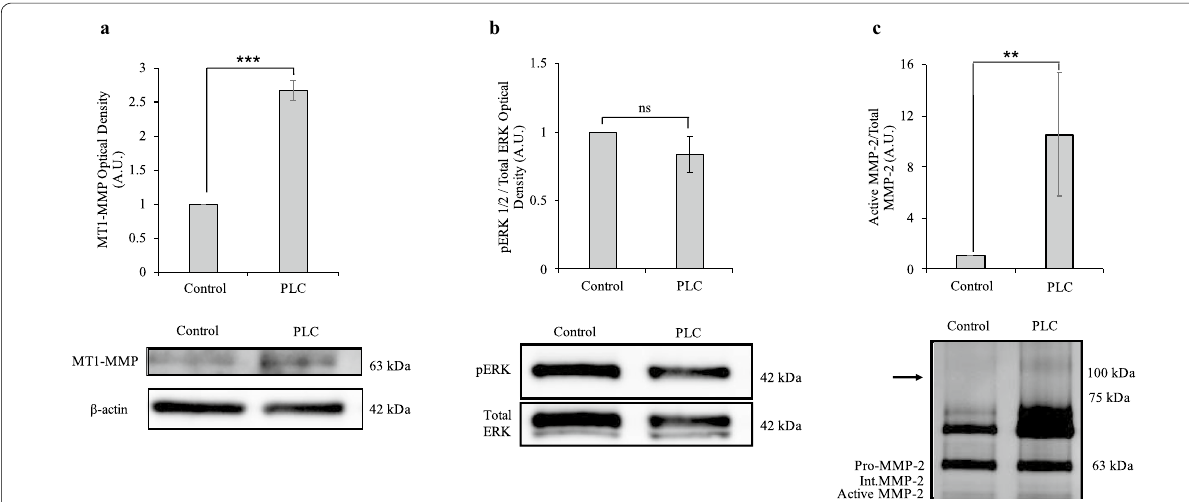
Fig. 6 PI-PLC treatment caused an increase in MT1-MMP protein and MMP-2 activity levels. a Densitometry quantification of MT1-MMP protein level normalized to β-actin in control A6 cells treated with PI-PLC. MT1-MMP protein levels significantly increased in PI-PLC-treated cells compared to untreated cells (set to 1). b Densitometry quantification of pERK normalized to total ERK levels. pERK protein levels did not significantly change following PI-PLC treatment. c Gelatin zymography was used to measure protein levels of secreted pro-, intermediate, and active MMP-2 following PI-PLC treatment in A6 cells. Data is presented as the ratio between active and total (pro-, intermediate, and active) MMP-2 levels between untreated cells and PI-PLC treated cells. Active/total MMP-2 levels significantly increased in the media of PI-PLC-treated cells compared to untreated cells (set to 1). Secreted MMP-9 protein could not be detected at the expected size of 92 kDa (shown by the arrow). Graphed data is based on 3 biological replicates (mean